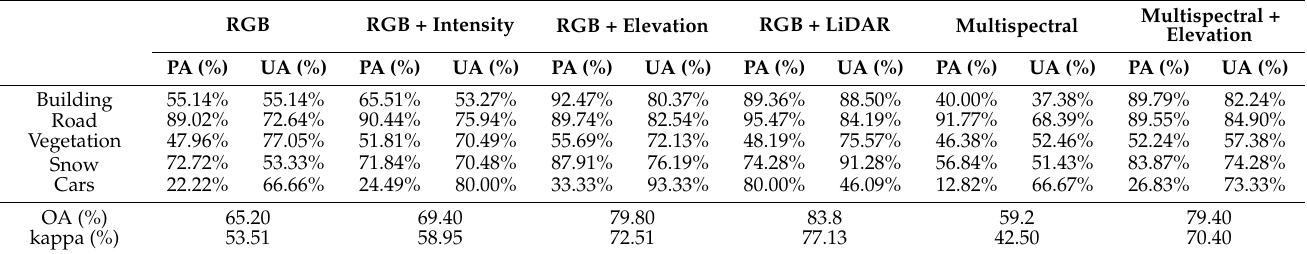
Table 2. Classification results of the six combinations using the SVM